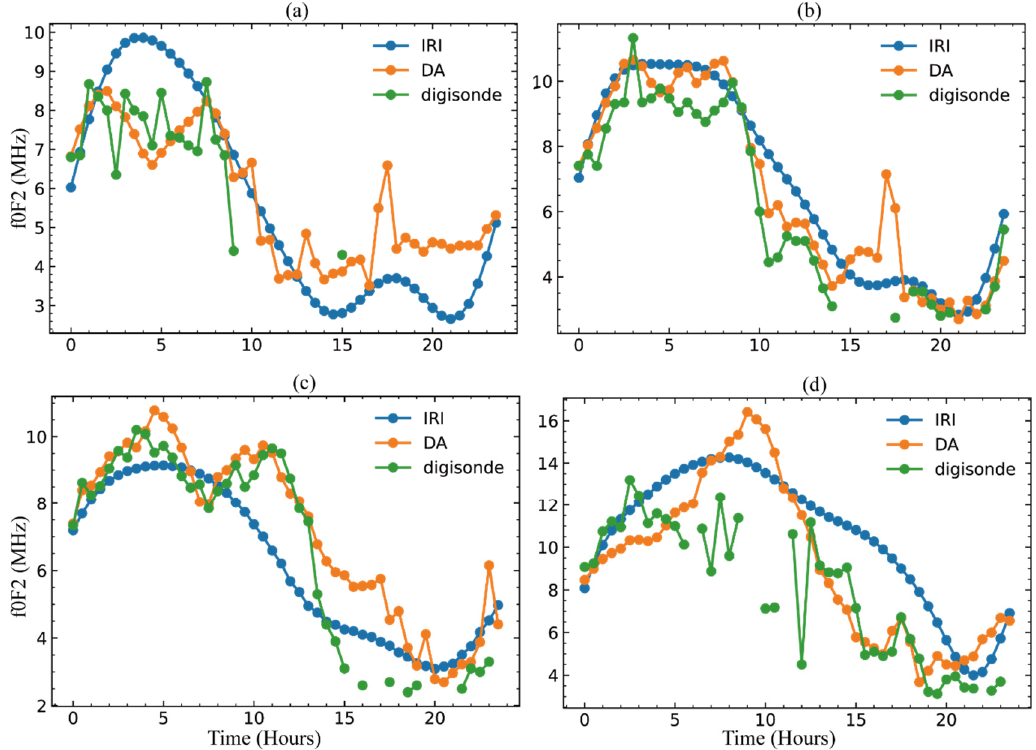
Figure 8. Comparison of foF2 variation at CP ( a ) and ZL ( b ) on 1 January 2015 and at MH ( c ) and FK ( d ) on 17 March 2015.